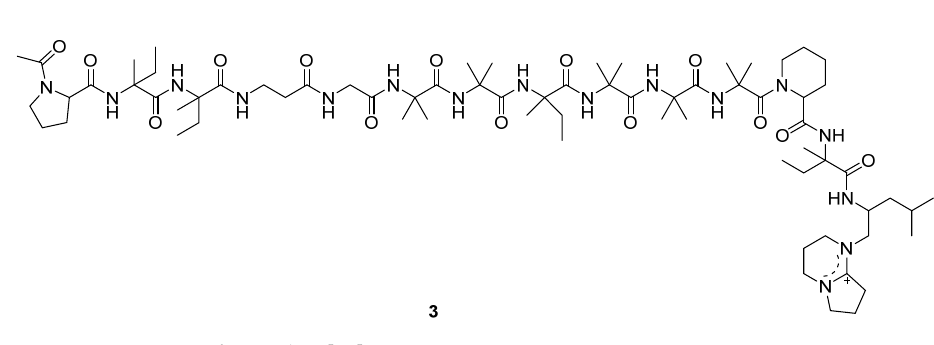
Figure 2. Structure of peptide 3 [15].